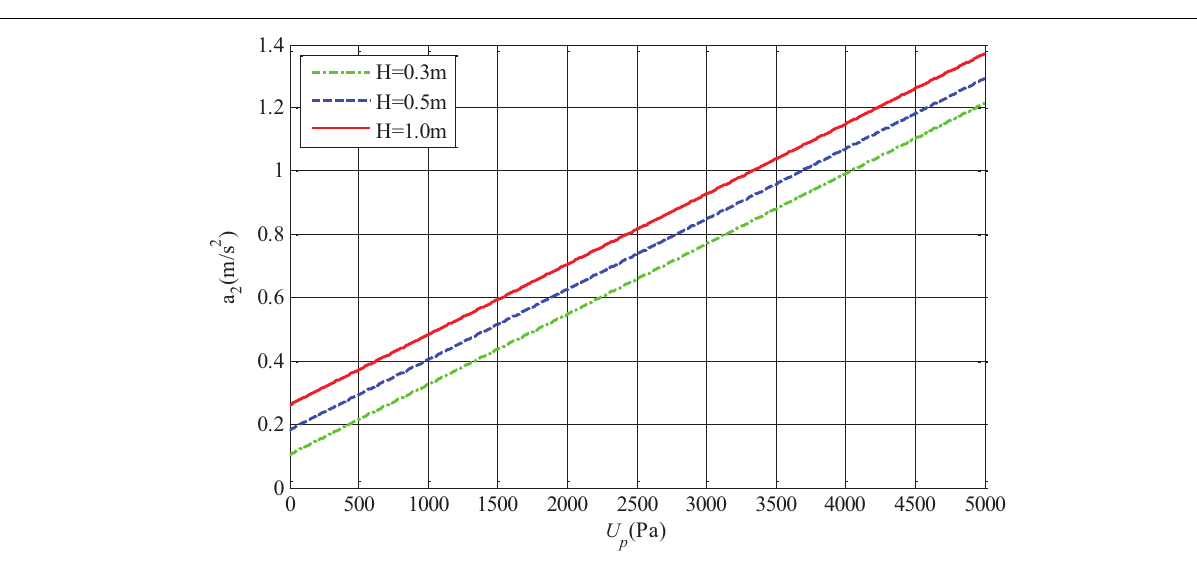
FIGURE 12 | Relationship between acceleration and pore water